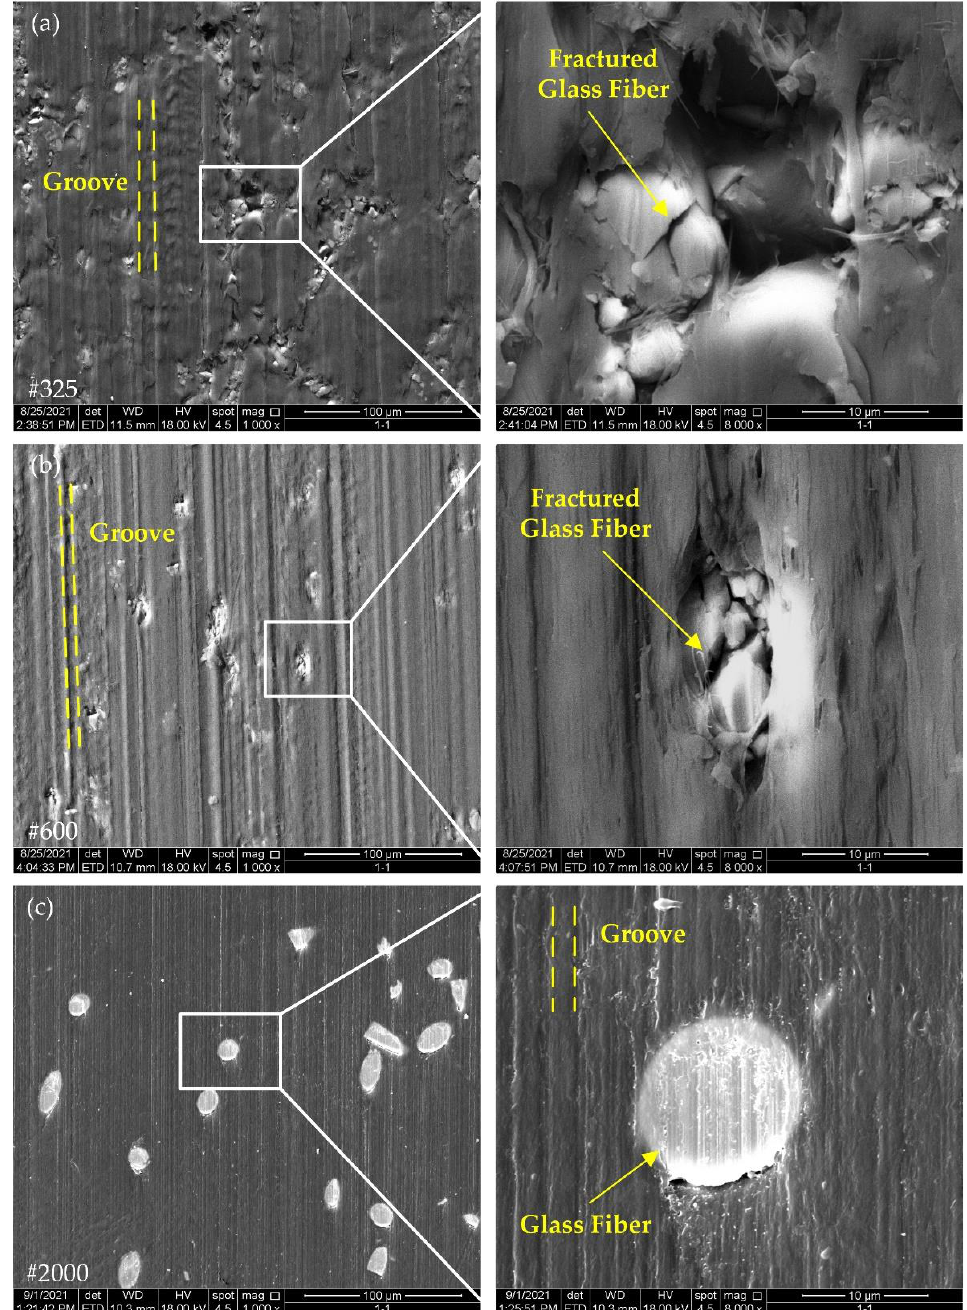
Figure 9. Surface morphology of GF10/PEEK with different grinding wheels: ( a ) grit size #325; ( b ) grit size #600; ( c ) grit size #2000.